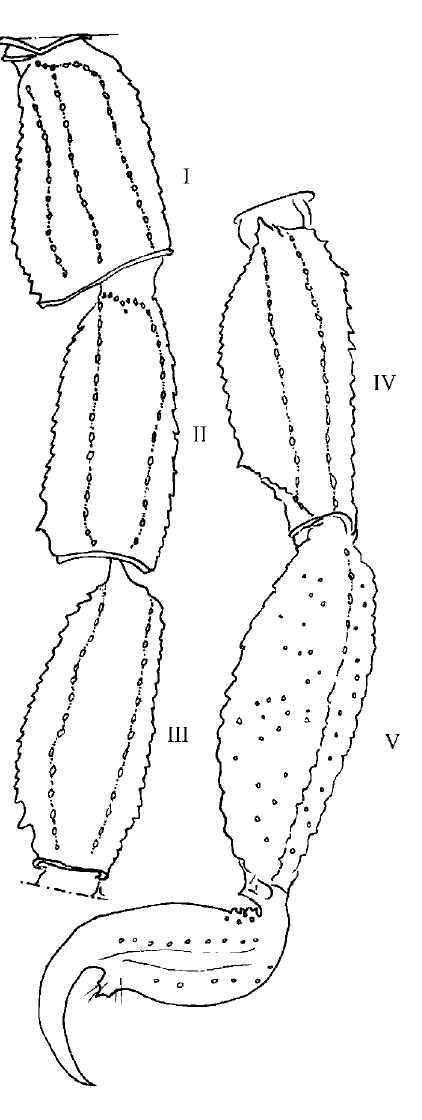
Figure 8 . Tityus gonzalespongai n. sp . Female. Caudal segments I-V and telson. Lateral